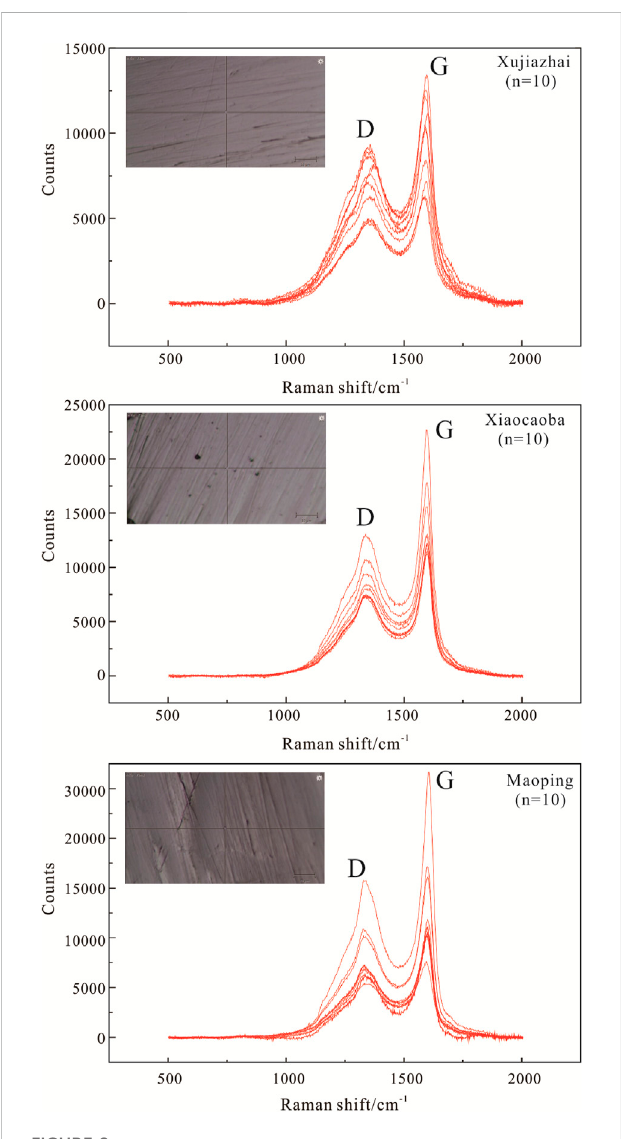
FIGURE 8 Raman microscopy measurement of bitumen with Raman spectra of D and G peaks, and optical photomicrographs under cross-polarized light. Scale: 10 μ m.